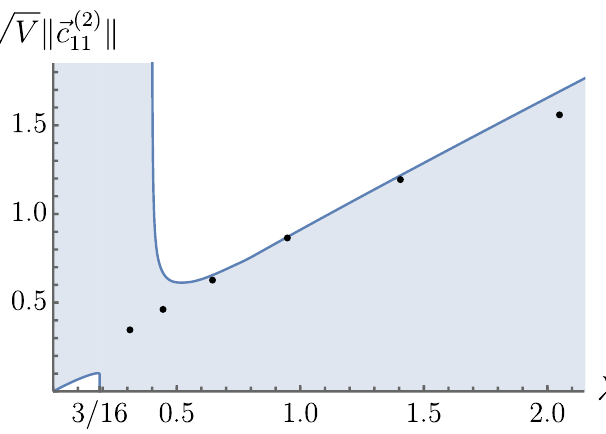
Figure 8 . Upper and lower bounds on the real parts of the overlap integrals of the lightest nontrivial eigenfunctions with holomorphic quadratic differentials on closed hyperbolic surfaces, as measured √ V k ~c (2) k . The blue region is allowed by the bounds. The filled circles correspond to the genus-2 by 11 surfaces ρ ( ‘ ) , defined in eq. (4.16), for ‘ = 3 , . . . , 8 , going from right to left.